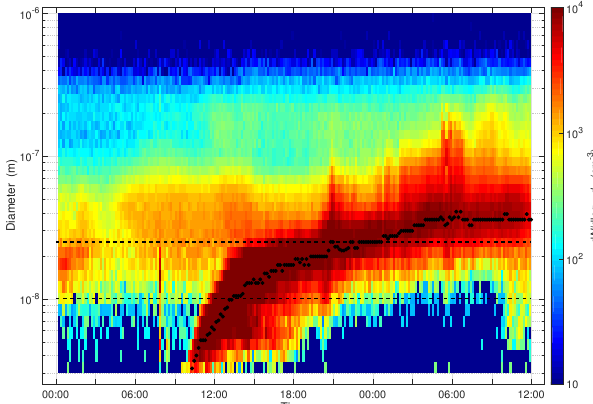
Figure 2. An example of a new particle formation event observed in Hyytiälä, Finland, 15–16 March 2011, illustrating the continuous growth of the newly formed aerosol particles for about 25h. The ge- ometric mean size of the fitted lognormal size distributions is shown with black dots, and the black dashed lines show the 10–25nm size range that is used for calculating the formation rate J nuc and growth rate GR nuc